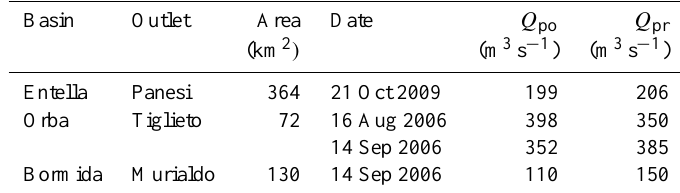
Table 6. Comparison between the values of the discharge peaks of the reference hydrographs ( Q pr ) and the peaks derived by the observations through level gauges ( Q po ) . These measurements are available for a reduced number of basins only.